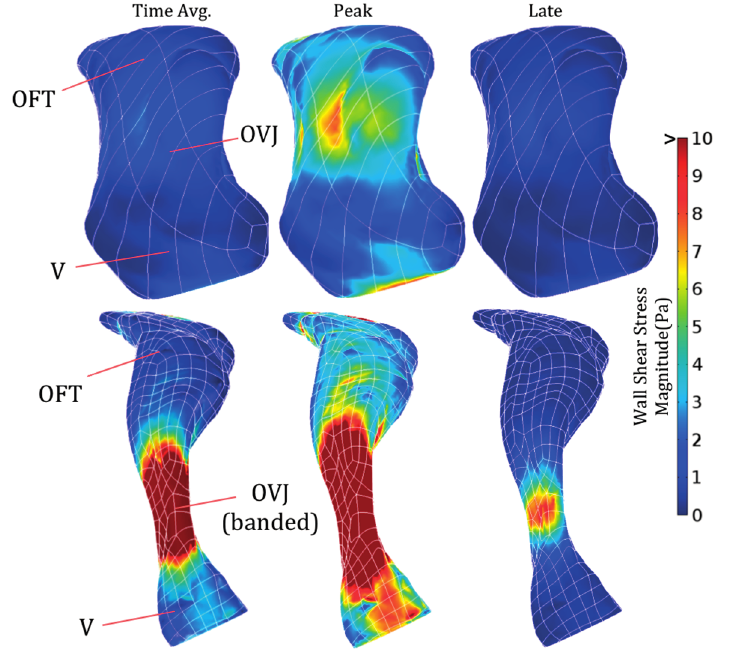
Figure 5. Wall shear stress magnitude for (top) control chick hearts and (bottom) OFT banded chick hearts at the time-averaged flow condition, during peak flow conditions and late in the cardiac cycle during retrograde flow. V, ventricle; OVJ, OFT/ventricle junction; OFT, outflow